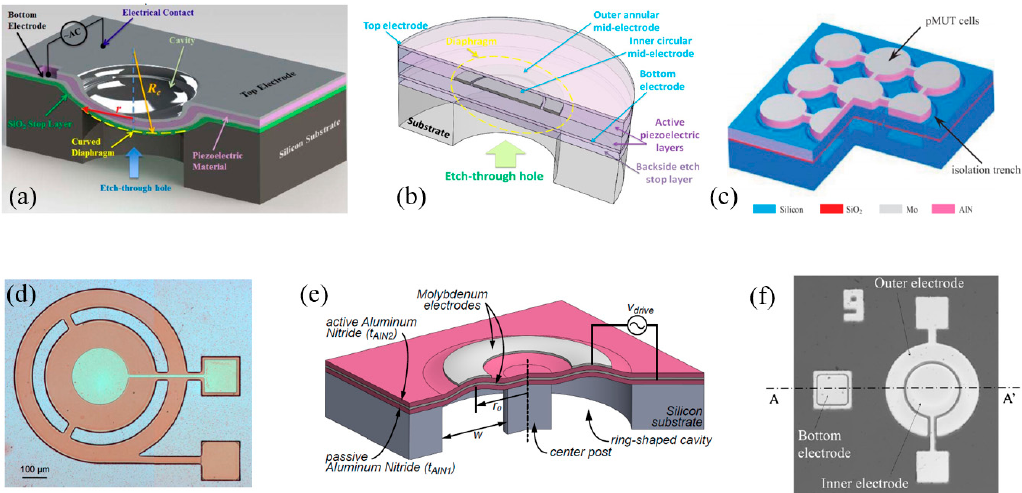
Figure 24. Schematic drawing or optical images of ( a ) curved diaphragm pMUT (Reproduced with permission from IEEE [126]), ( b ) bimorph pMUT (Reproduced with permission from IEEE [149]), ( c ) pMUT array with an isolation trench between cells (Reproduced with permission from IEEE [151]), ( d ) flexurally suspended pMUT (Reproduced with permission from IEEE [152]), ( e ) ring-shaped pMUT (Reproduced with permission from TRF [153]), and ( f ) dual-electrode pMUT (Reproduced with permission from Elsevier [145]).